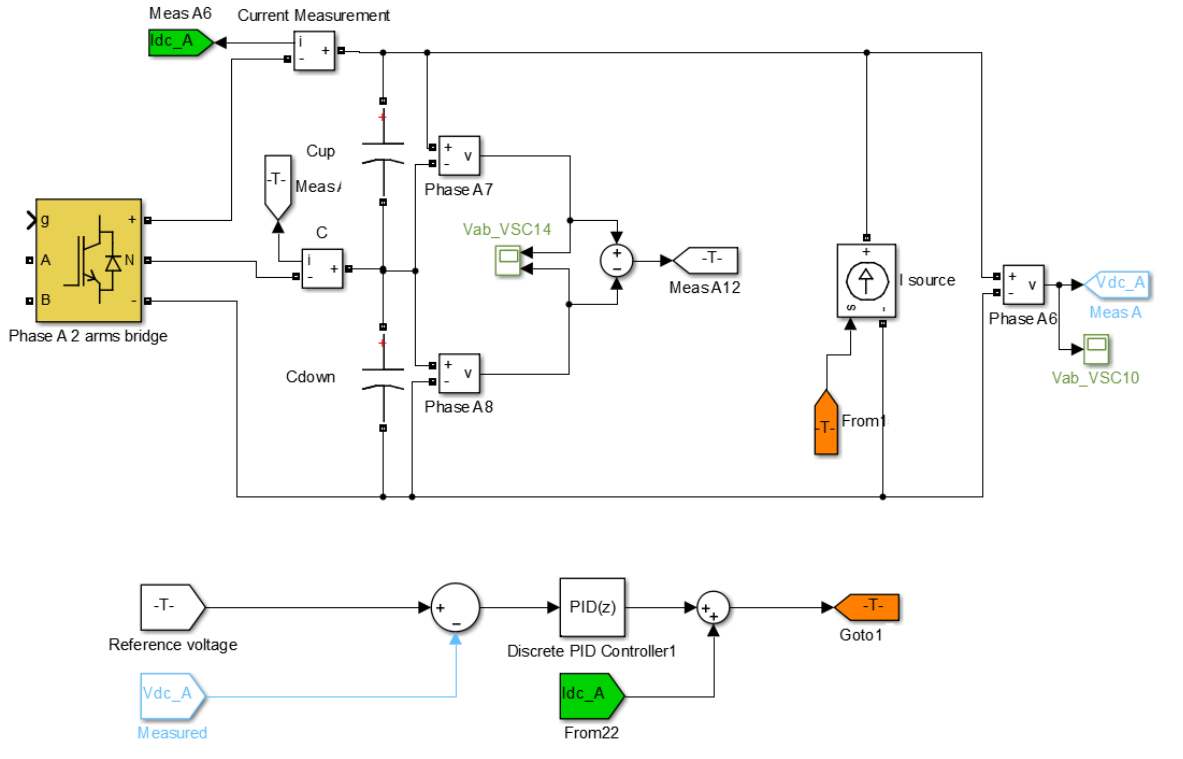
Figure 3. Single-phase source model through a proportional integral (PI)